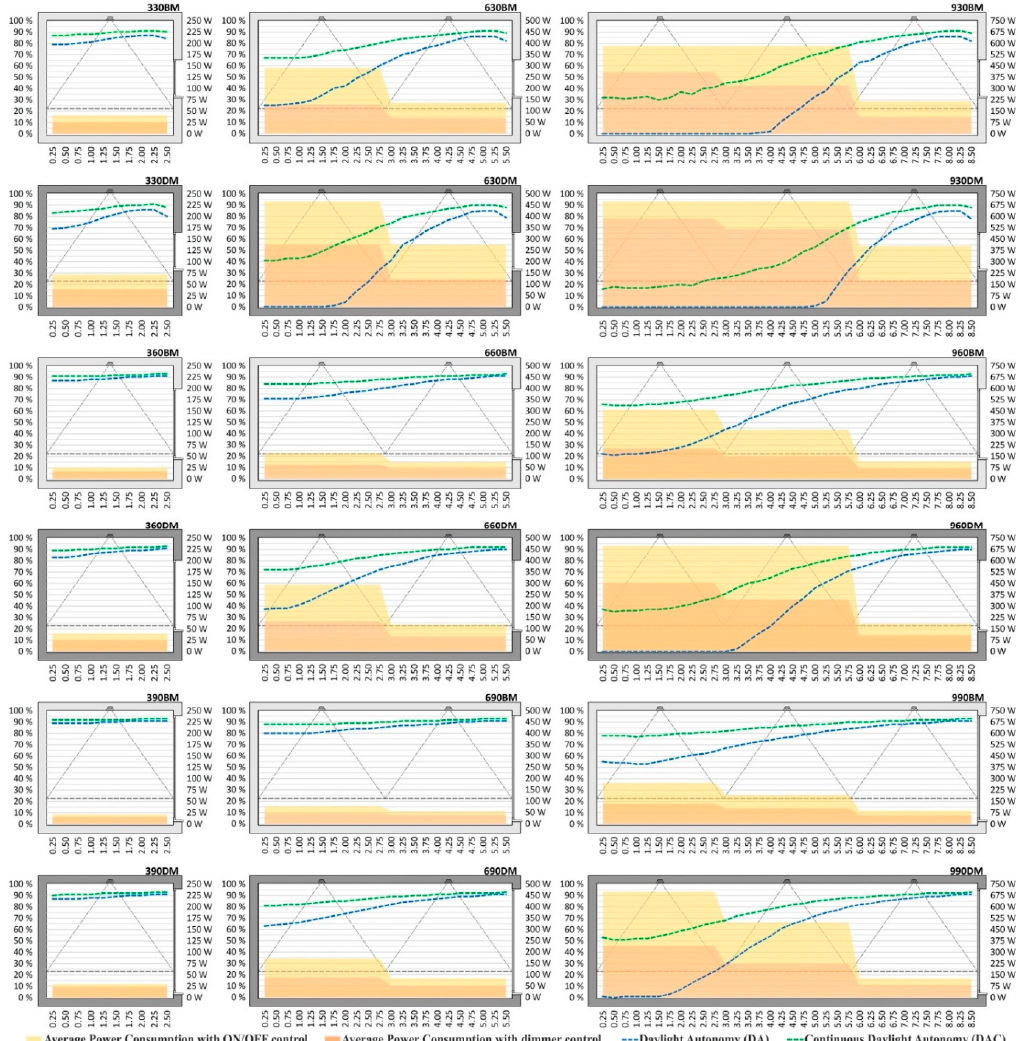
Figure 6. Dynamic daylight performance metrics and average power consumption according to different smart controls for room models located in Madrid. Table 10. Average power consumption in W/m 2 of different lighting smart controls in Madrid.